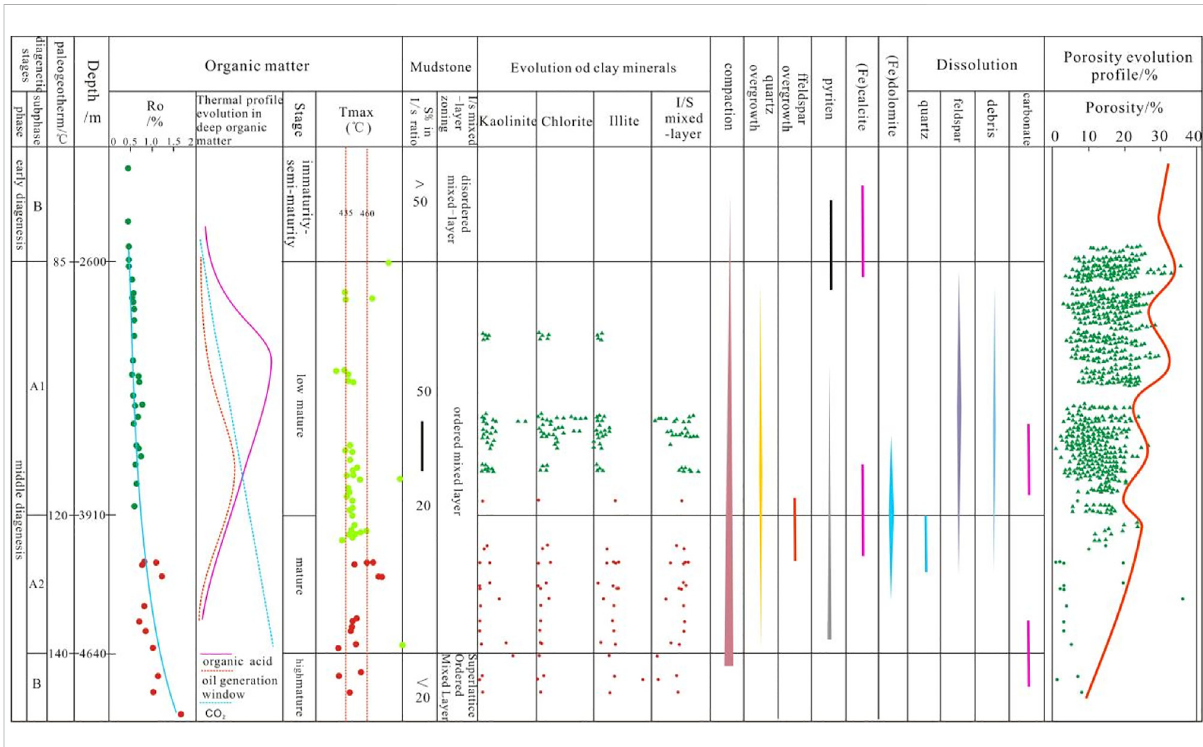
FIGURE 7 Division of diagenetic stages of the Gaoshangpu oil fi eld (modi fi ed by Jidong oil fi eld exploration and development research